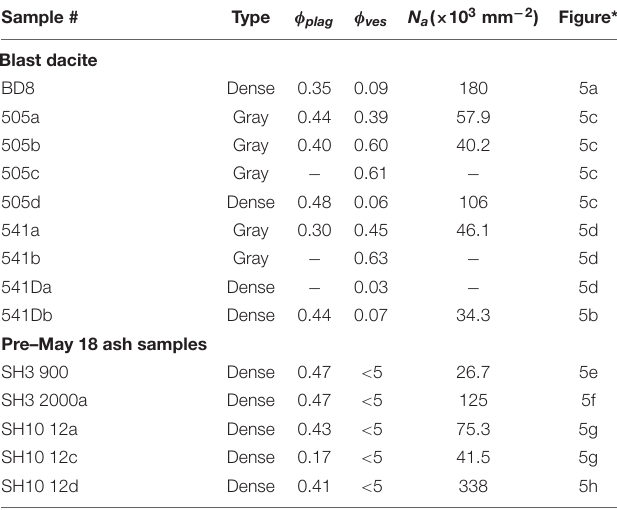
TABLE 2 | Textural characteristics of Mount St Helens eruptive products. Sample